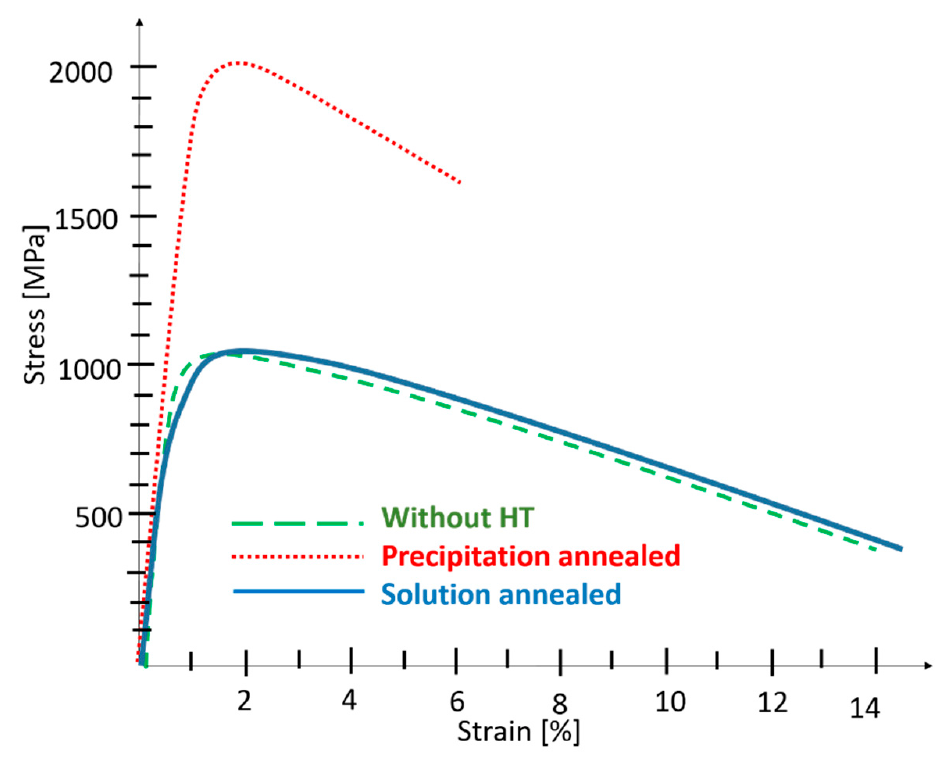
Figure 14. Representative stress-strain curves for the specimens from the hybrid parts. HT, heat treatment.